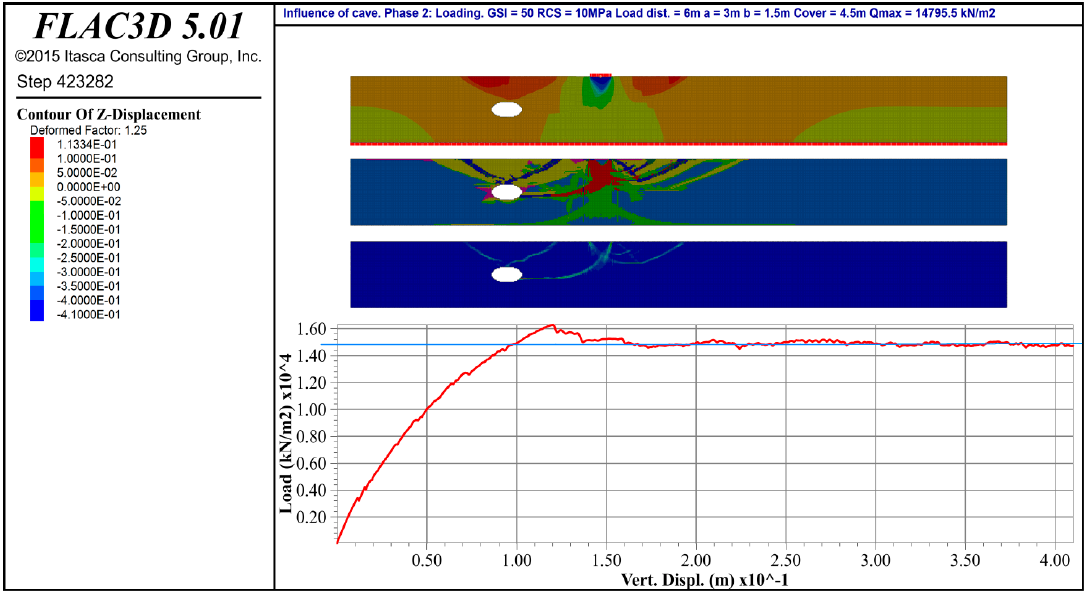
Figure 4. Case IEH-2. Eccentricity E/a = 2 ( mixed failure mechanism, by punching shear with inclined cut surfaces, plus classic plastic failure wedges). Appl. Sci. 2019 , 9 , x FOR PEER REVIEW